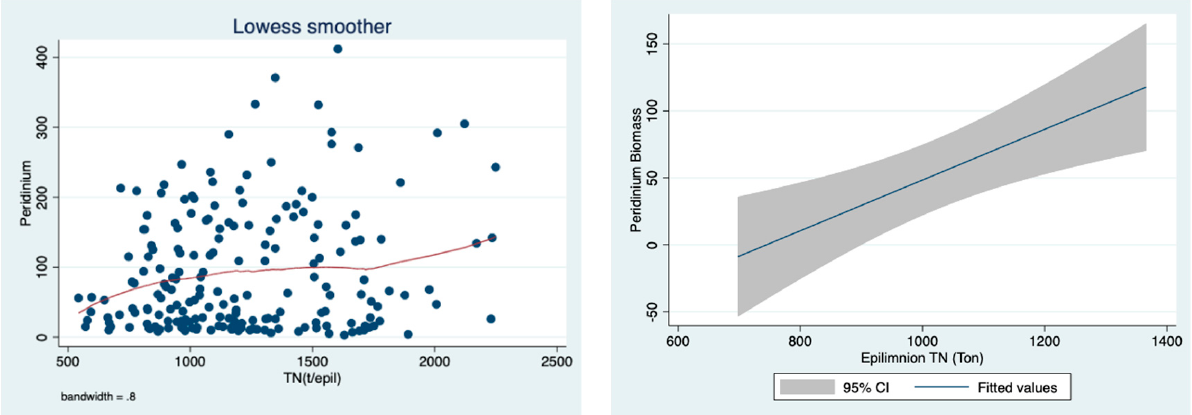
Figure 12. Smoother (0.8 bandwidth) trend of changes of monthly (1–12) means of Peridinium wet biomass (g/mn 2 ) (left) and total nitrogen load (ton) in the epilimnion of Lake Kinneret, averaged for the period from 1970 to 2018.